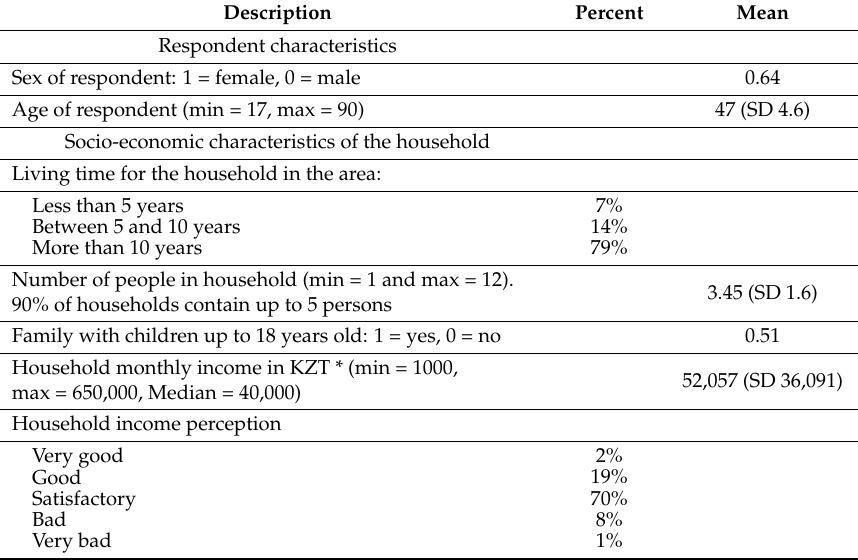
Table 2. Description of investigated households (SD = standard